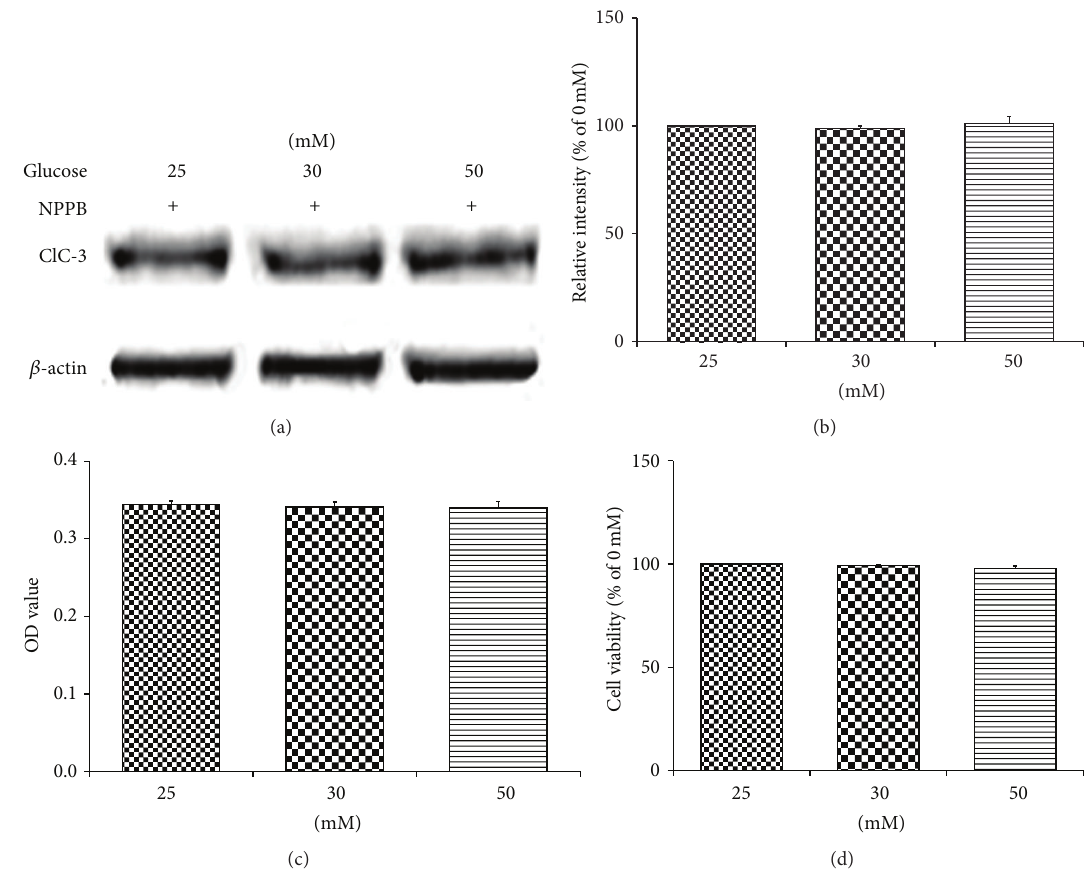
Figure 7: Western blot analysis of HT22 cell lysates from control and low and high glucose groups, in the presence of 0.1M NPPB, at 24 h, stained for ClC-3 protein expression (a) reveals no change in the total ClC-3 expression, in terms of their intensity, among groups (b). MTT assay of HT22 cells, cultured under same conditions, showed no significant changes in the cell viability among the groups (c and